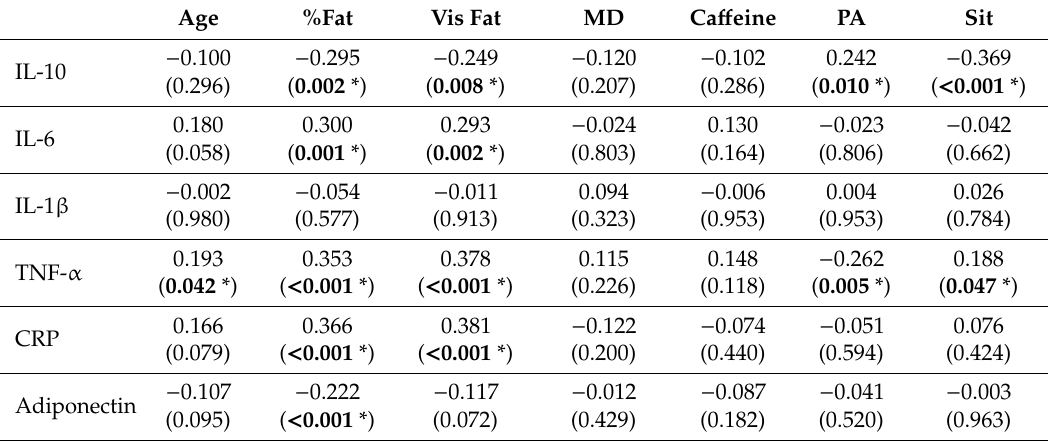
Table 6. Bivariate correlations between dependent and independent variables in